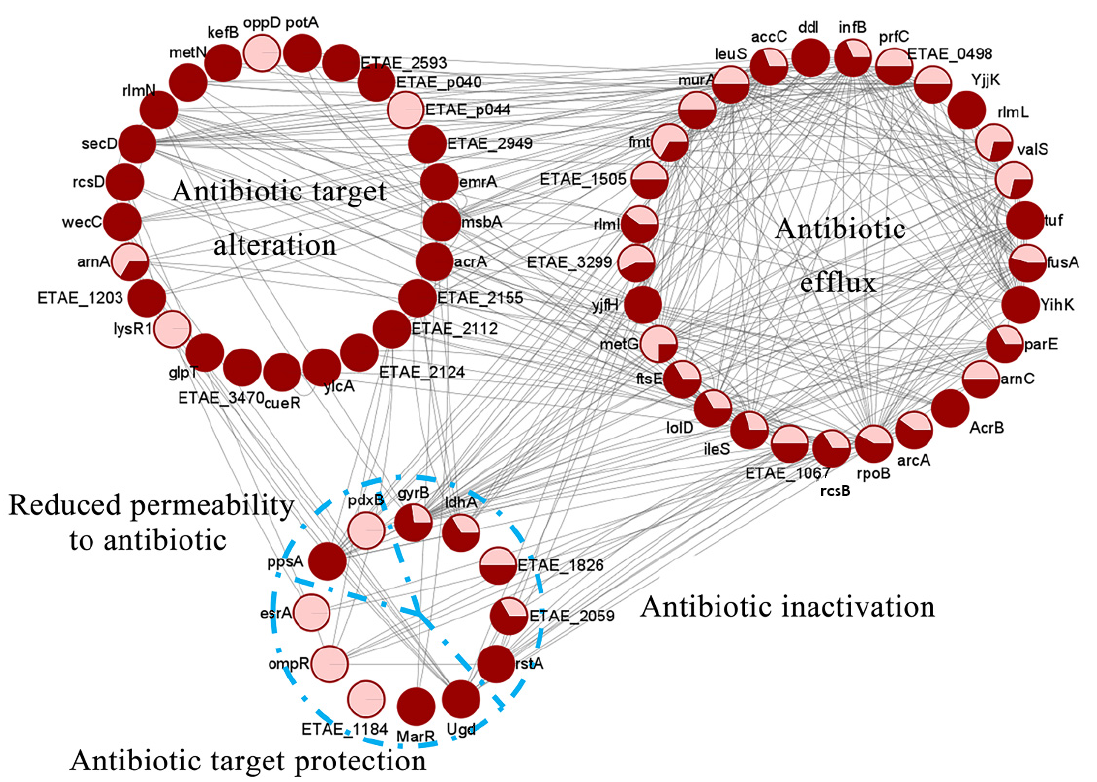
Figure 6. Analysis of protein-protein interaction networks of 66 AMR proteins in E. tarda . The pink and red cycles represent the proportions of Kac and Ksu modifications in single AMR proteins,